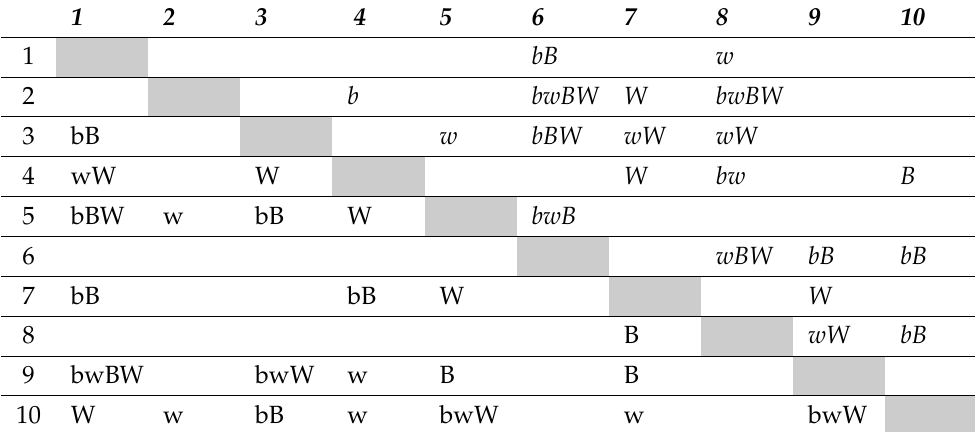
Table 1. Overview of results from the analyses in Sections 3.2–3.6: The ten bacterial pairs with the highest (half-matrix left bottom) and the lowest (half-matrix right top) stability in each analysis are marked with b (between) and w (within) phases and corresponding capital letters for changes in comparison to